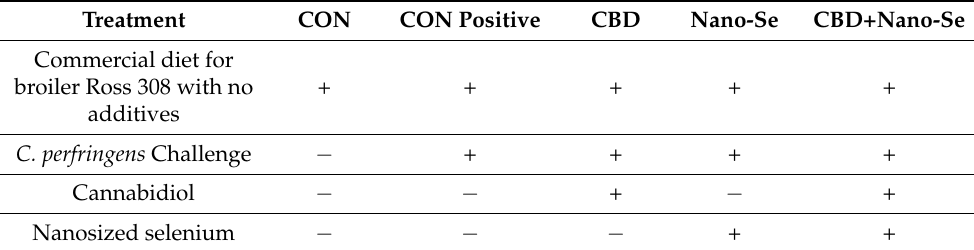
Table 2. Dietary treatments applied in the chicken